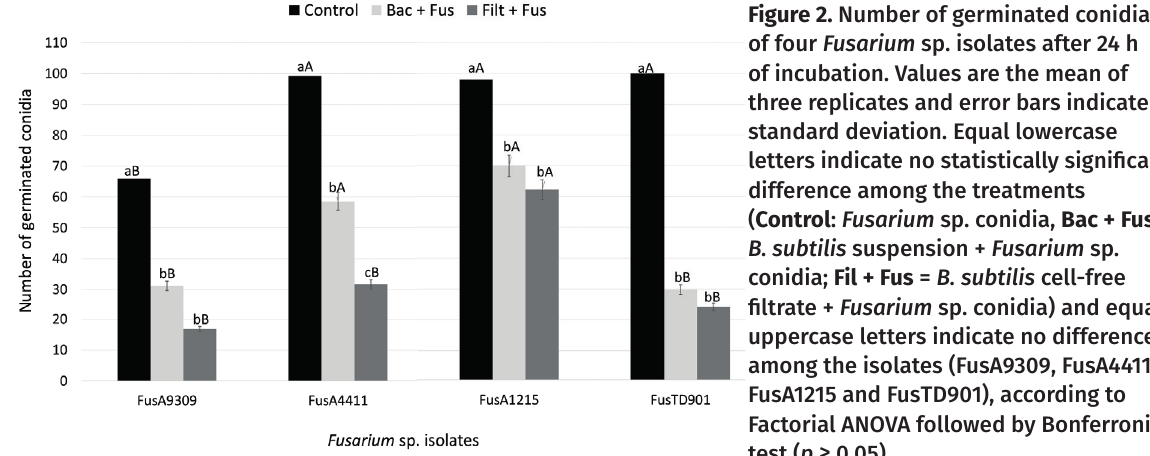
Figure 2. Number of germinated conidia of four Fusarium sp. isolates after 24 h of incubation. Values are the mean of three replicates and error bars indicate standard deviation. Equal lowercase letters indicate no statistically signifi cant difference among the treatments ( Control : Fusarium sp. conidia, Bac + Fus : B. subtilis suspension + Fusarium